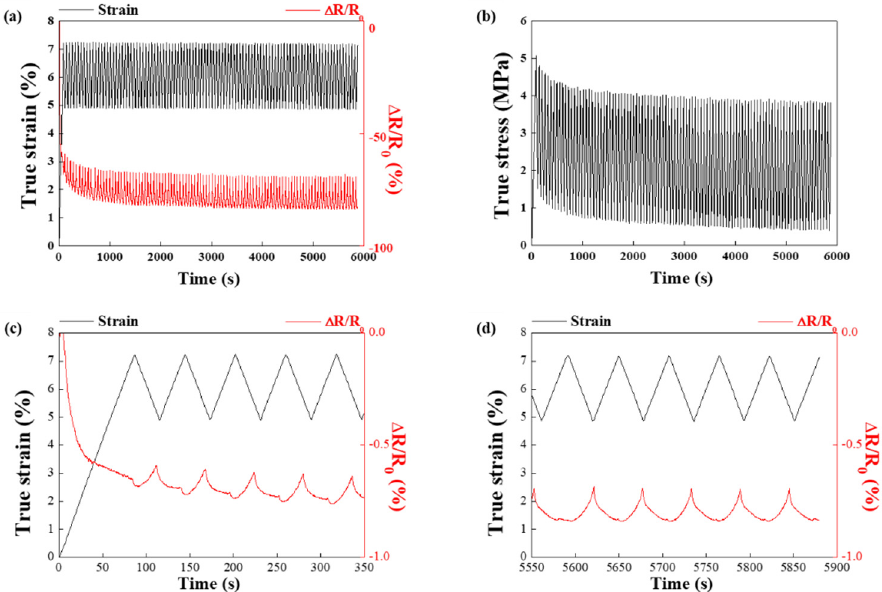
Figure 7. ( a , b ) Compression testing of 3D-printed TPU/Cu/MWCNT composites up to 100 cycles ( c ) first and ( d ) last 5 cycles.